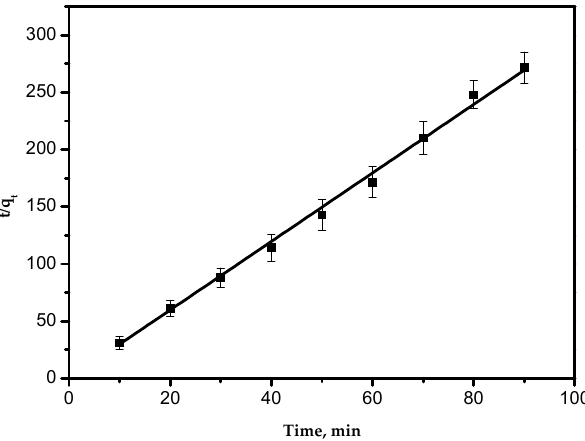
Figure 7. Pseudo-second-order adsorption Figure 7. Pseudo ‐ second ‐ order adsorption kinetics.